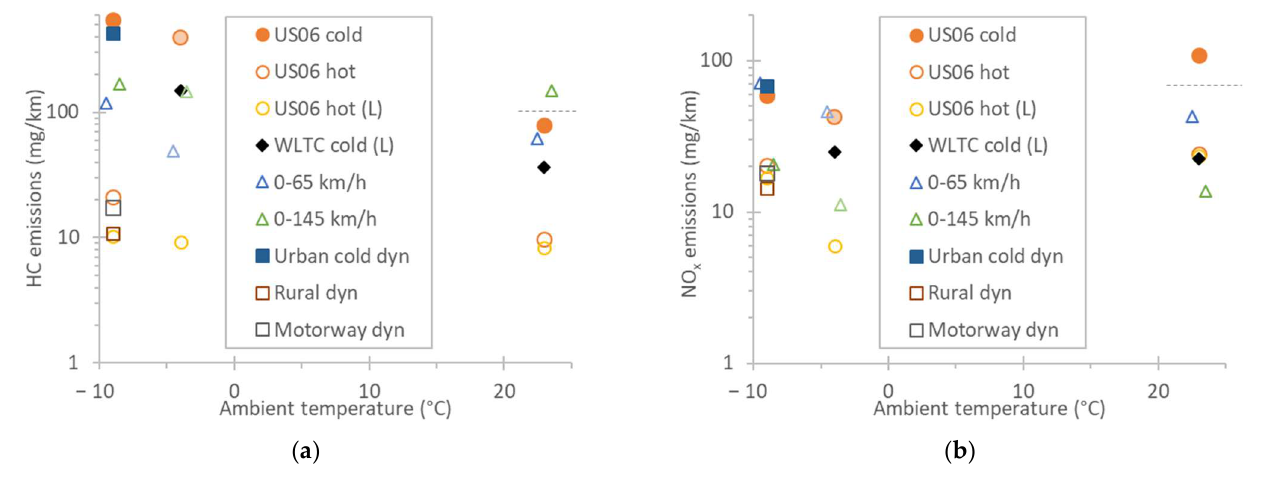
Figure 2. Emissions for various tests at different ambient temperatures. All tests with 84% payload (1850 kg test mass), except those with “L” and the −4 °C tests where the test mass was lower (1550 kg). Auxiliaries were activated only at the −9 °C tests. Solid symbols are cold start tests, while open symbols are hot start tests. Lighter colors indicate tests with lower payload (mass). The dotted line shows the limit for the type approval cycle WLTC. ( a ) HC. ( b ) NO x .